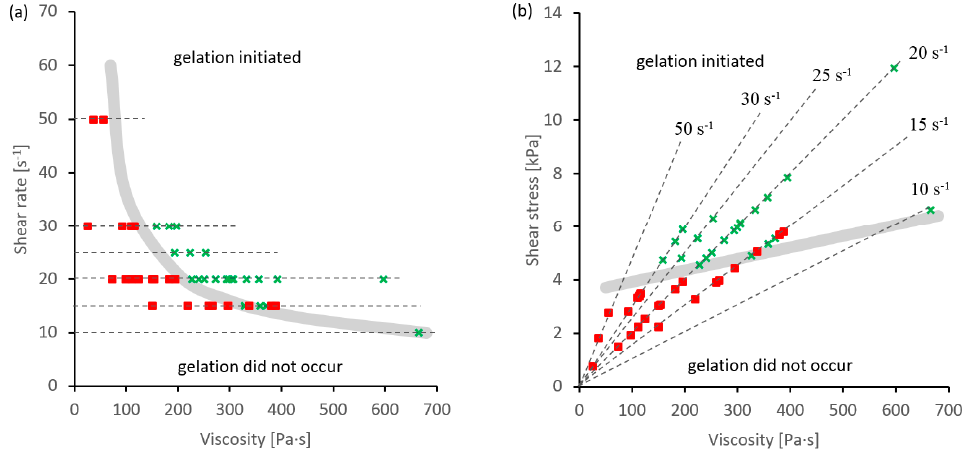
Figure 2. Maps showing flow conditions that did (green crosses) or did not (red filled squares) initiate phase changes, plotted with respect to: ( a ) viscosity and shear rate; ( b ) viscosity and shear stress. Thick grey lines indicate (approximate) boundaries between successful and unsuccessful initiation; dashed lines indicate experiments using the same shear rates. The viscosities were measured at the shear rates indicated.